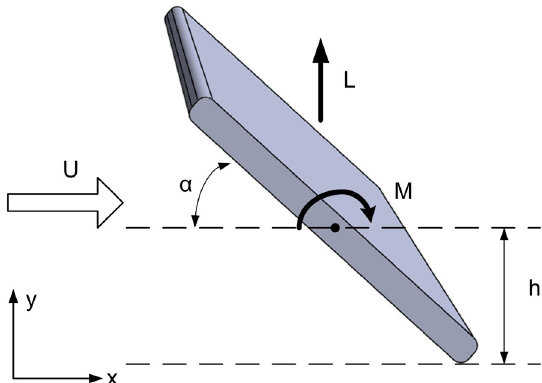
Figure 3. Cross sectional view of the fluttering belt (thin